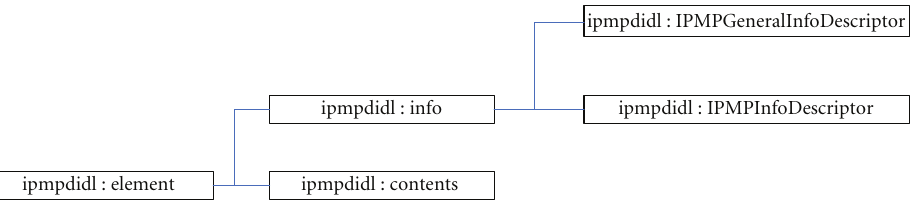
Figure 2: Structure of an IPMP DIDL